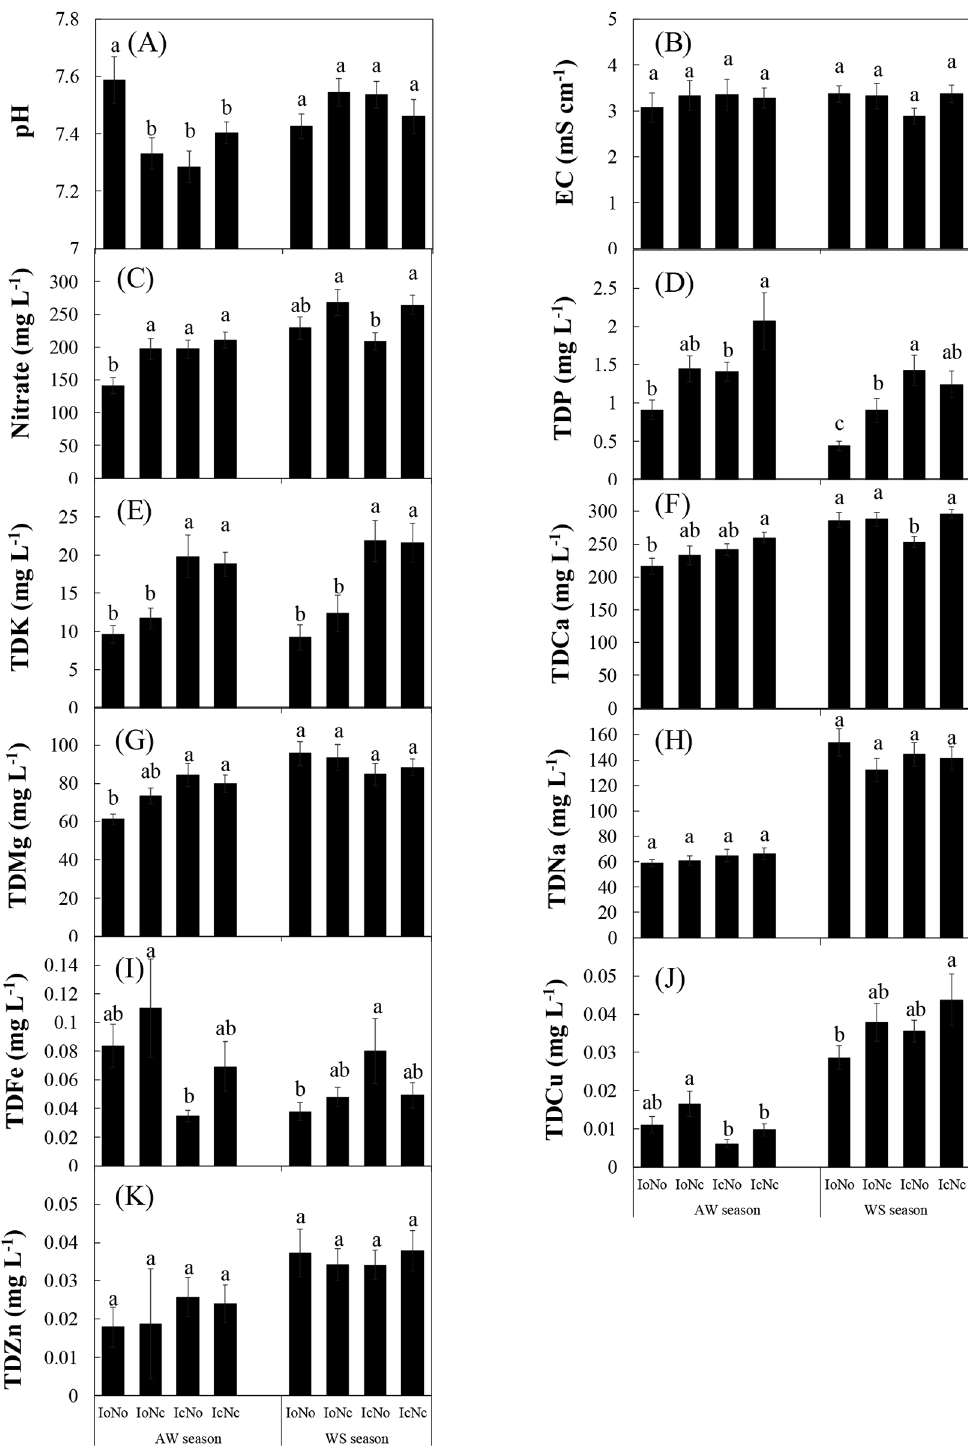
Fig 4. Mineral elements concentrations in leachate under different treatments in the autumn-winter (AW) and winter-spring (WS) seasons. Treatments codes are the same as in Table 1. Bars represent standard errors (n = 4). The same letter for each sampling time in the same copping season indicates no significant difference (P = 0.05).